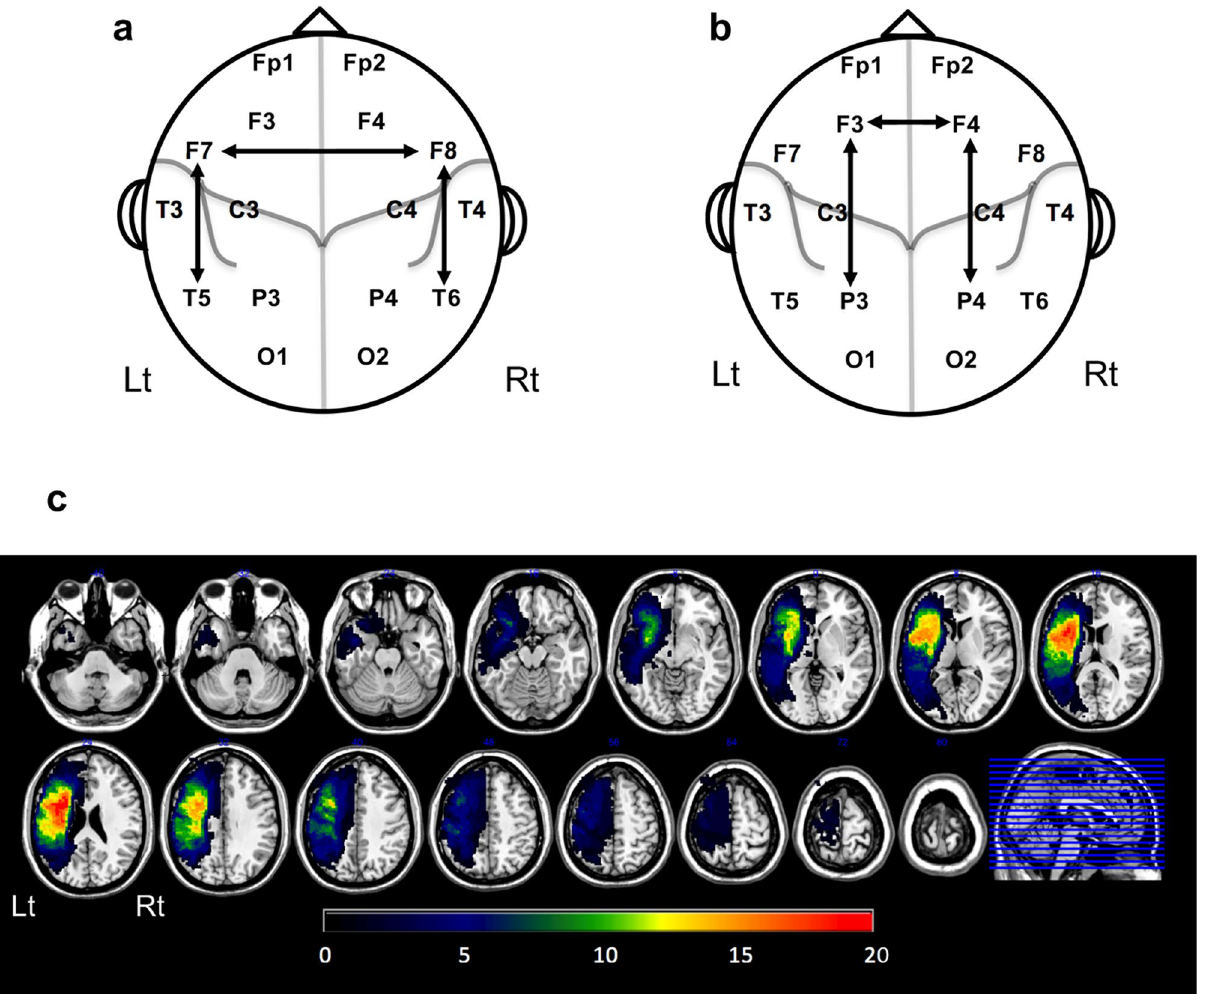
Figure 1. Maps of electrode pairs and stroke lesions in this study. ( a ) Electrode pairs used for the computation of the F7F8-PSI, F7T5-PSI, and F8T6-PSI. They are located in the motor language-related regions. ( b ) Electrode pairs (F3F4, F3P3, and F4P4) spatially adjacent to those in ( a ) (F7F8, F7T5, and F8T6) used for evaluation of the effect of artifacts. They are not located in the motor language-related regions. ( c ) A map of the ischemic stroke lesion distribution in 31 patients. The colors indicate the number of patients with lesions. PSI phase synchrony